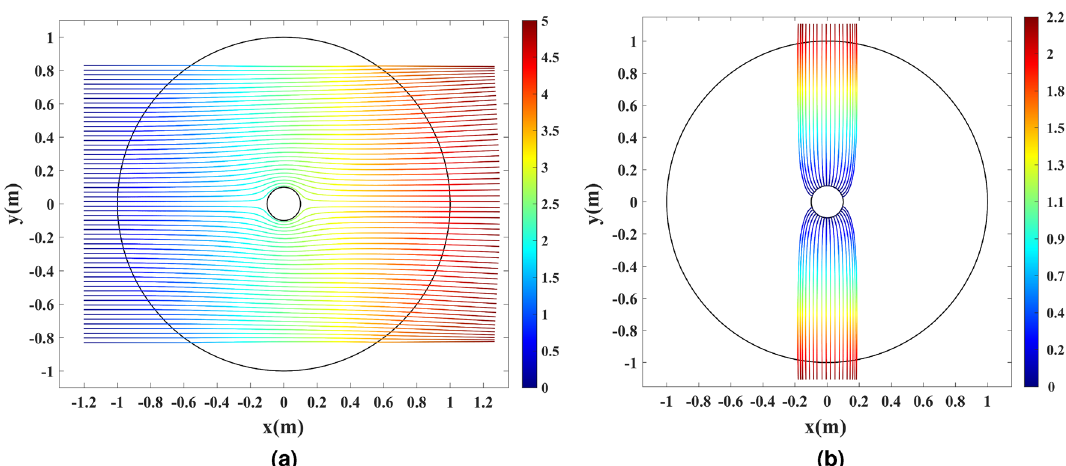
Figure 10. Ray-tracing simulation of the physical space with the refractive index depicted in Fig. 9. ( a ) The cloaking effect for 60 parallel rays launched along the x -axis. ( b ) The directivity enhancement effect for 36 equally-spaced rays launched from the inner rim. The color expression presents the optical path length in meters.